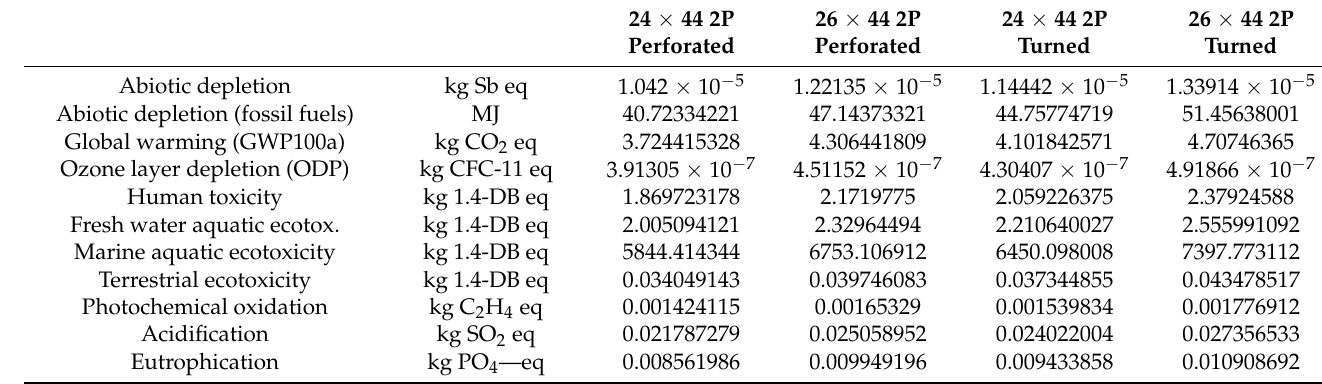
Table 22. Global impact of each geometry and production methodology, by impact category and for one cork stopper